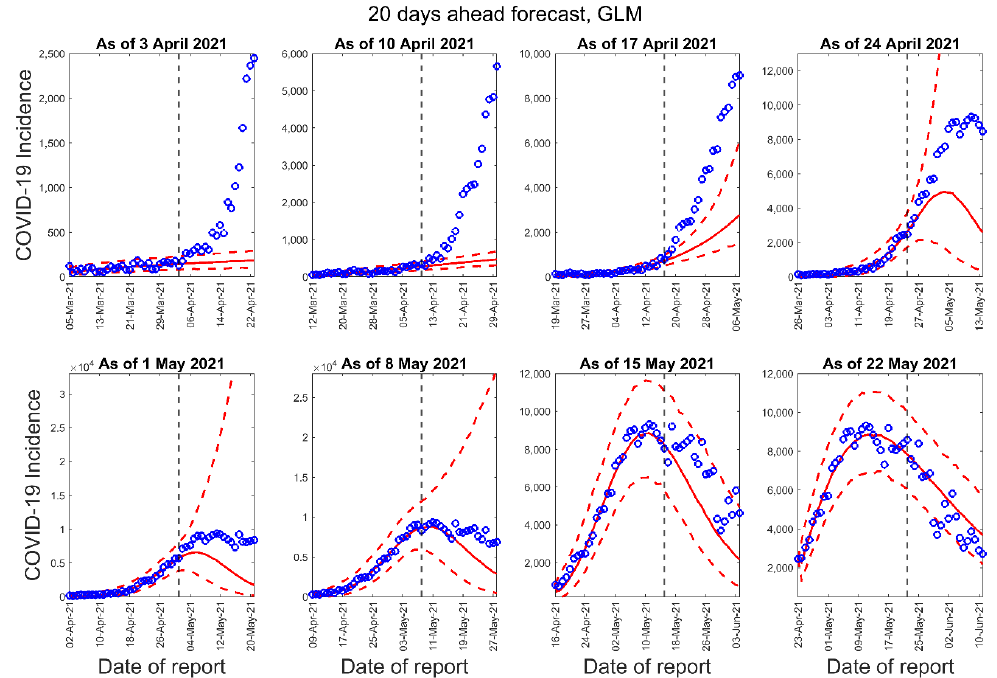
Figure 6. Twenty-days ahead forecasts of the COVID-19 epidemic curves in Nepal by calibrating the GLM model for eight different periods. Blue circles correspond to the data points; the solid red line indicates the best model fit, and the red dashed lines represent the 95% prediction interval. The vertical black dashed line represents the time of the start of the forecast period.